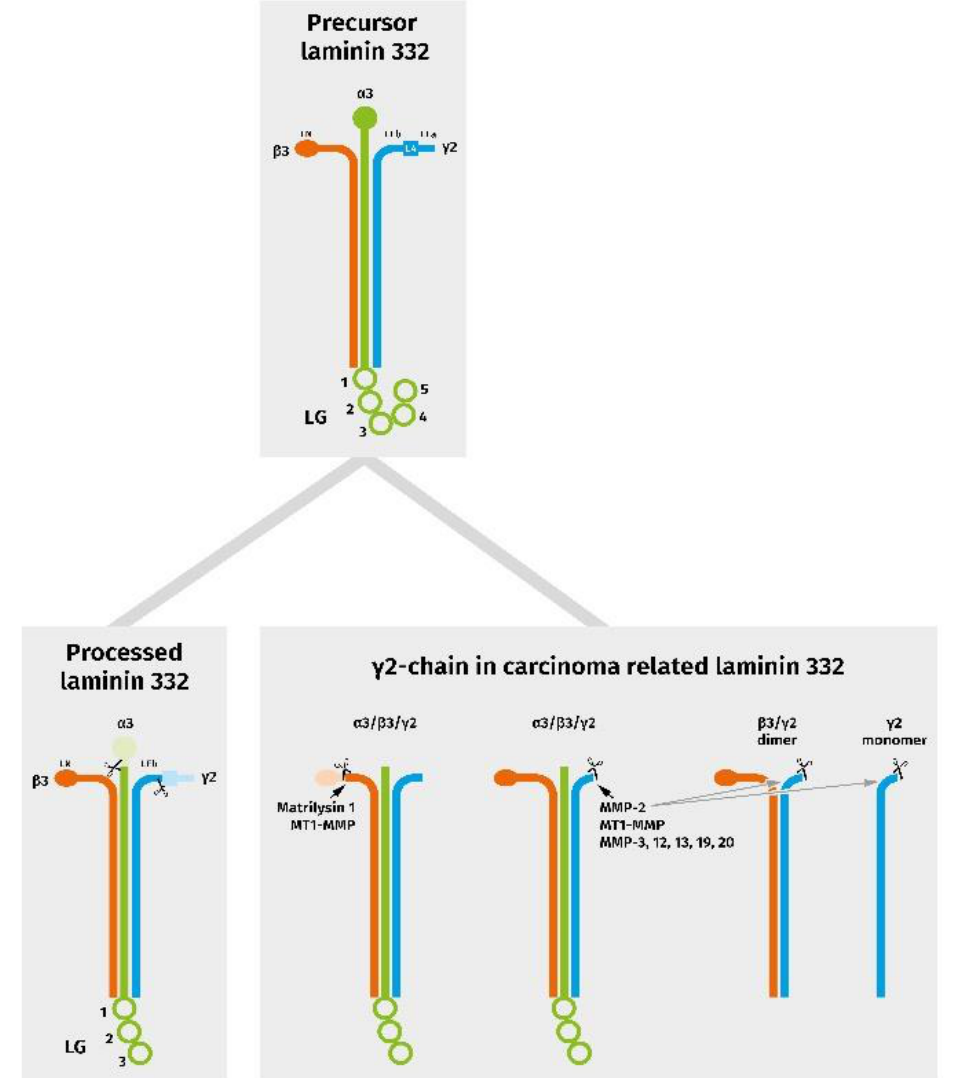
Figure 2. Schematic diagram representing chain assembly and proteolytic events in physiologically processed, as well as in carcinoma-related, laminin 332 variants. In tumors, the γ 2 chain can be present in association with the α 3 chain and a truncated β 3 chain, as well as with a further specific cleavage in a heterotrimeric, dimeric, and/or monomeric form.